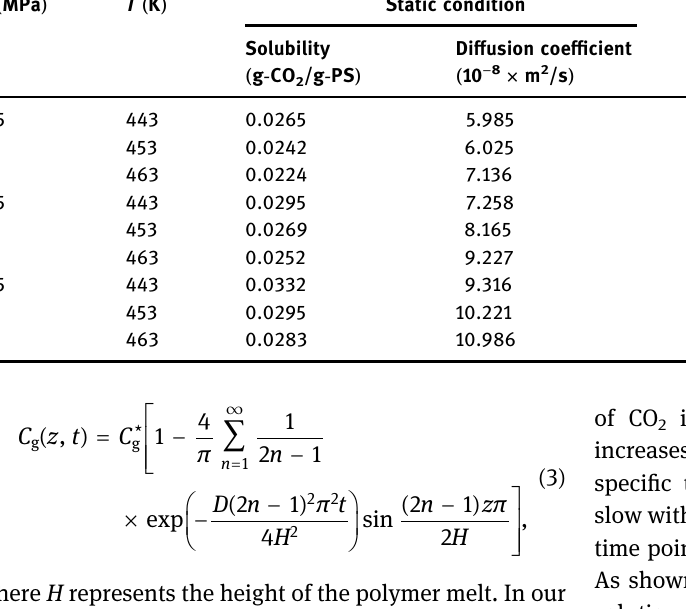
P ( MPa ) T ( K ) Static condition Conical agitator ( 2 r/s )